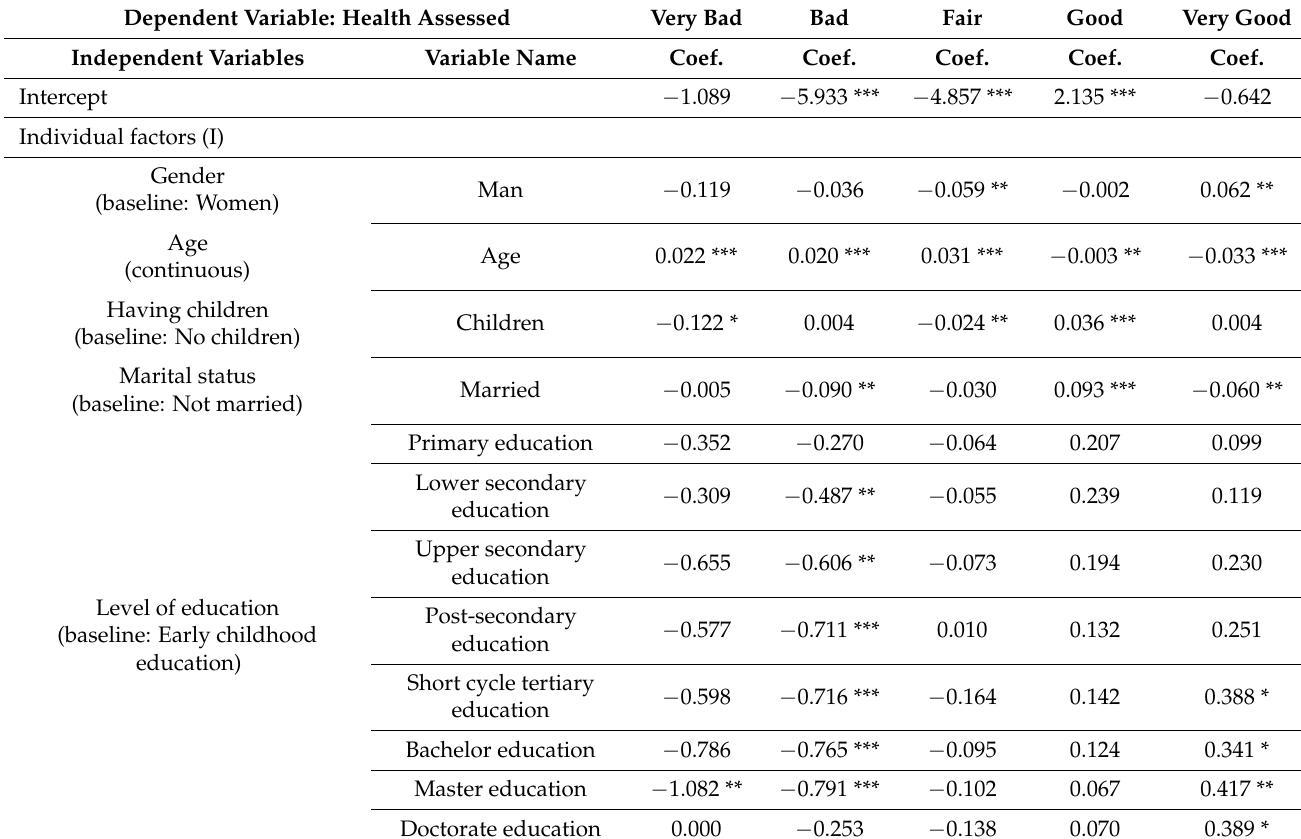
Table 2. Probit regression results for the GDP